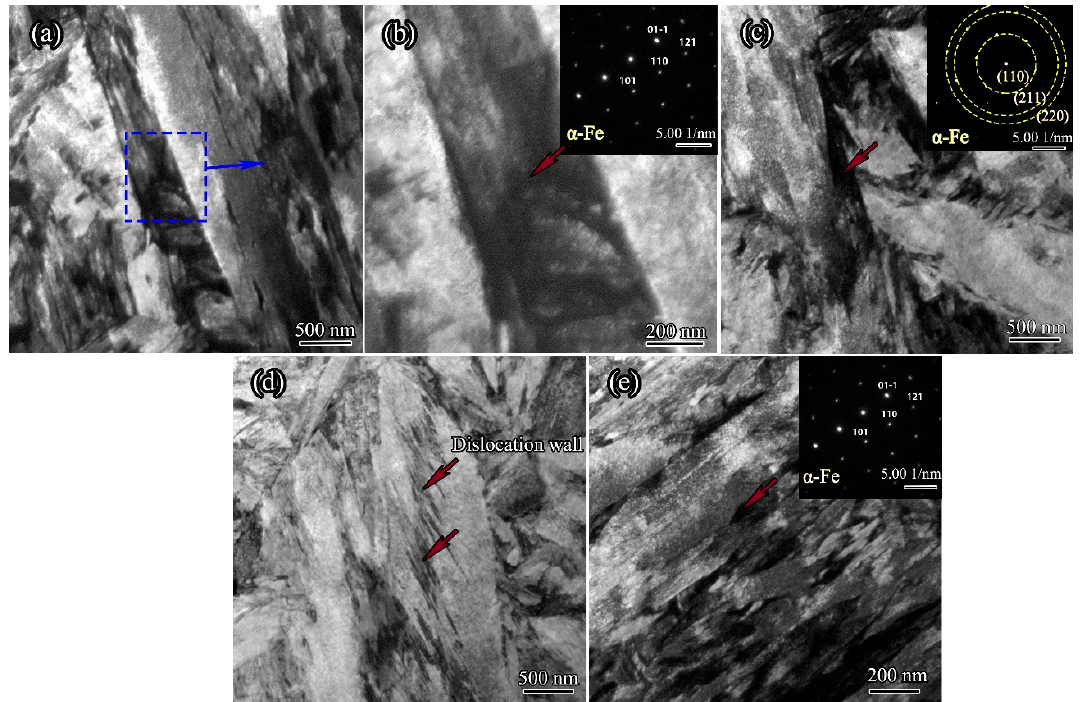
Figure 10. Bright field image showing the microstructures of 300M steel obtained by isothermal holding at 900 °C for 5 s and quenching: ( a ) ferrite lath in martensite; ( b ) the zoomed view of ferrite lath; ( c ) distorted ferrite due to martensite transformation; ( d ) dislocation wall within a martensite lath; and ( e ) initial formed nuclei on the interfaces of the martensitic laths.